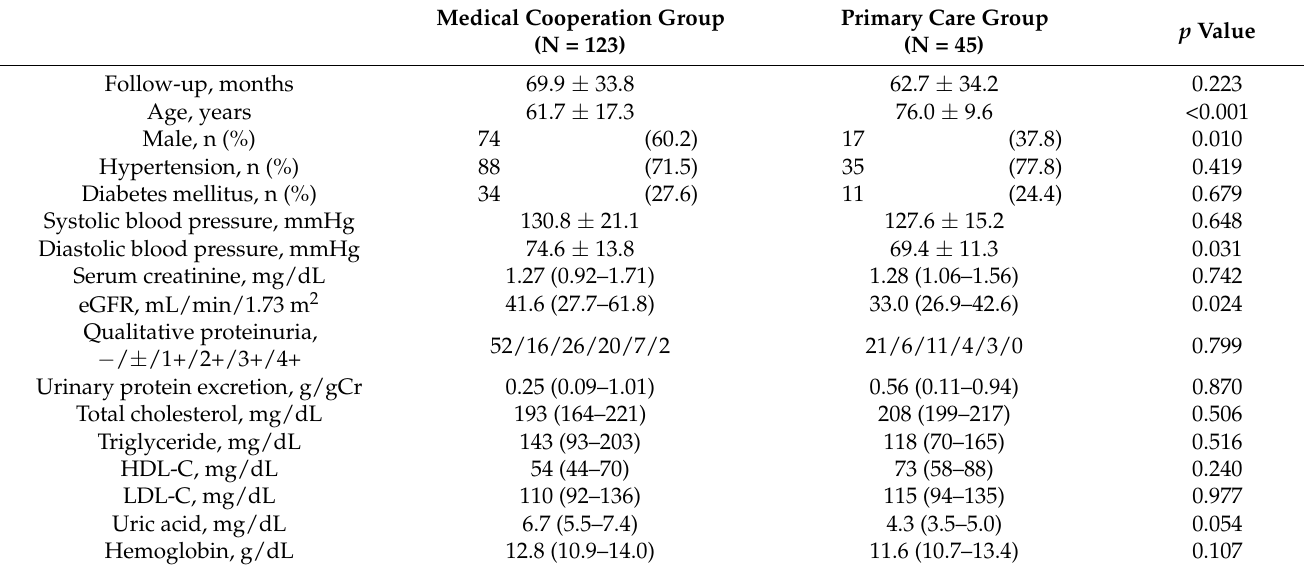
Table 1. Characteristics of the study